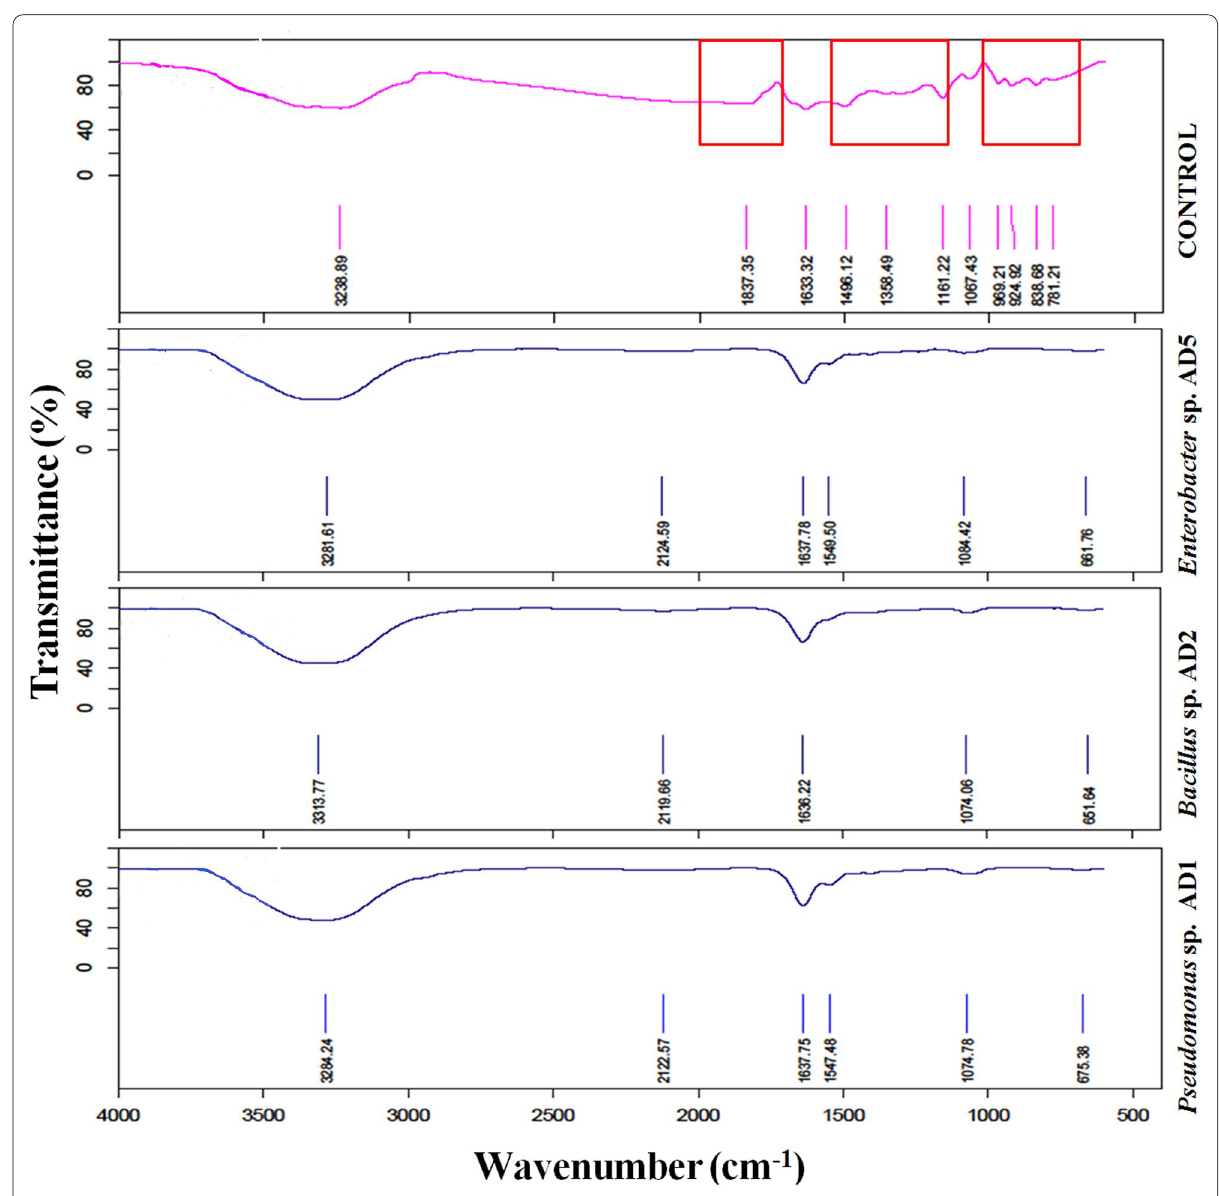
Fig. 3 FTIR analysis for decolourized and control